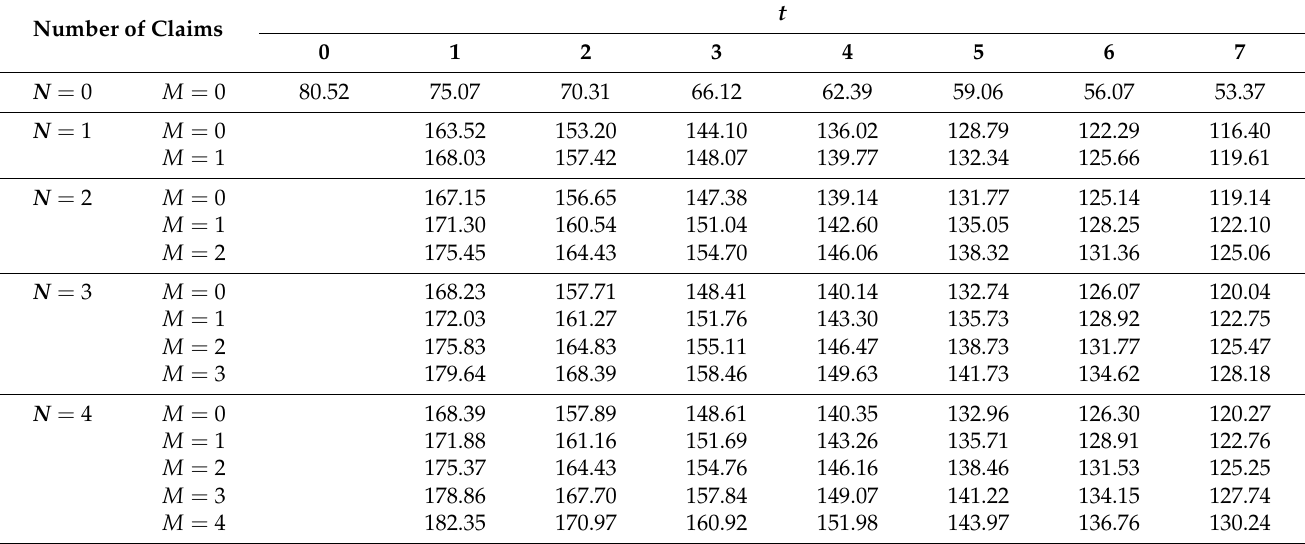
Table 6. Bonus-malus premiums based on Poisson binomial-Lindley beta distribution for the fre- quency component and gamma-Lindley distribution for the severity component with a total claim size of S =